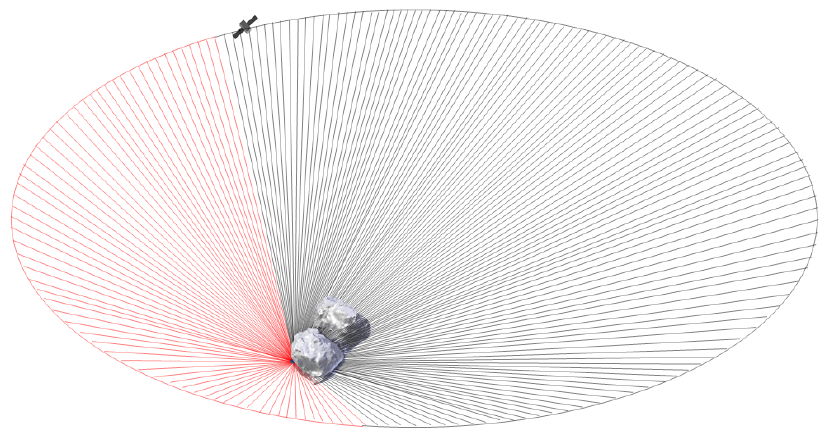
Figure A1. The CONSERT signal propagation throughout the nucleus between OCN and LCN. The red rays correspond to the direct visibility mode used in this paper (adapted from [6]).